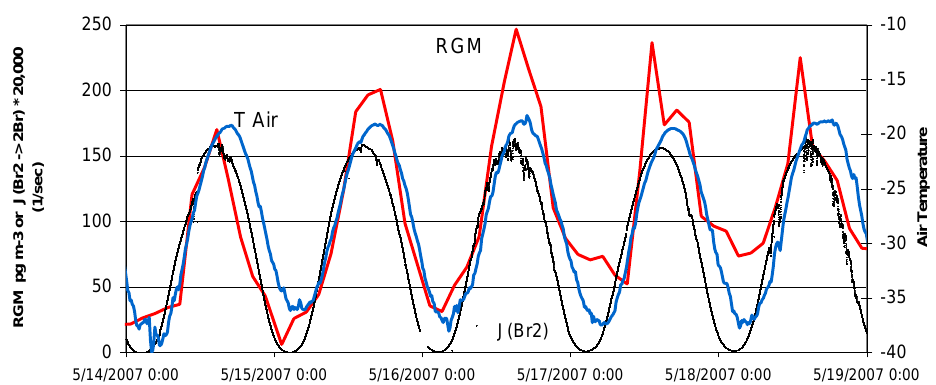
Fig. 7. Reactive gaseous mercury (RGM), J(Br 2 + hν = > 2Br), and air temperature at Summit, Greenland, 14–19 May 2007. Correlation coefficients for RGM-J(Br 2 ) and RGM-Temperature are r = 0 . 85 and r = 0 . 84,